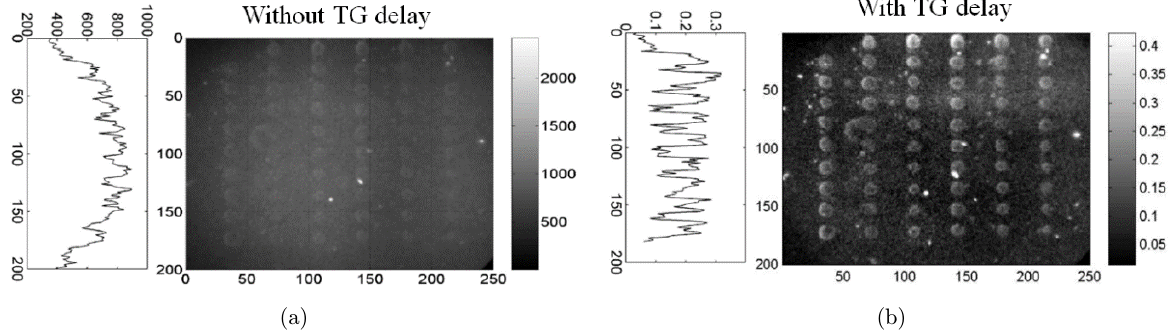
Fig. 7. FluorescenceimagesofDNAmicroarraymarkedbycyanine3.(a)Theimagewastakensynchronouslywiththeexcitationpulses. (b) The image was taken with a set of time delays, and the amplitude map of cyanine 3 can be calculated. The line pro¯les across the ¯rst column of the DNA microarray images are shown at left in (a) and (b), respectively. Reprinted with permission from Ref. 29.